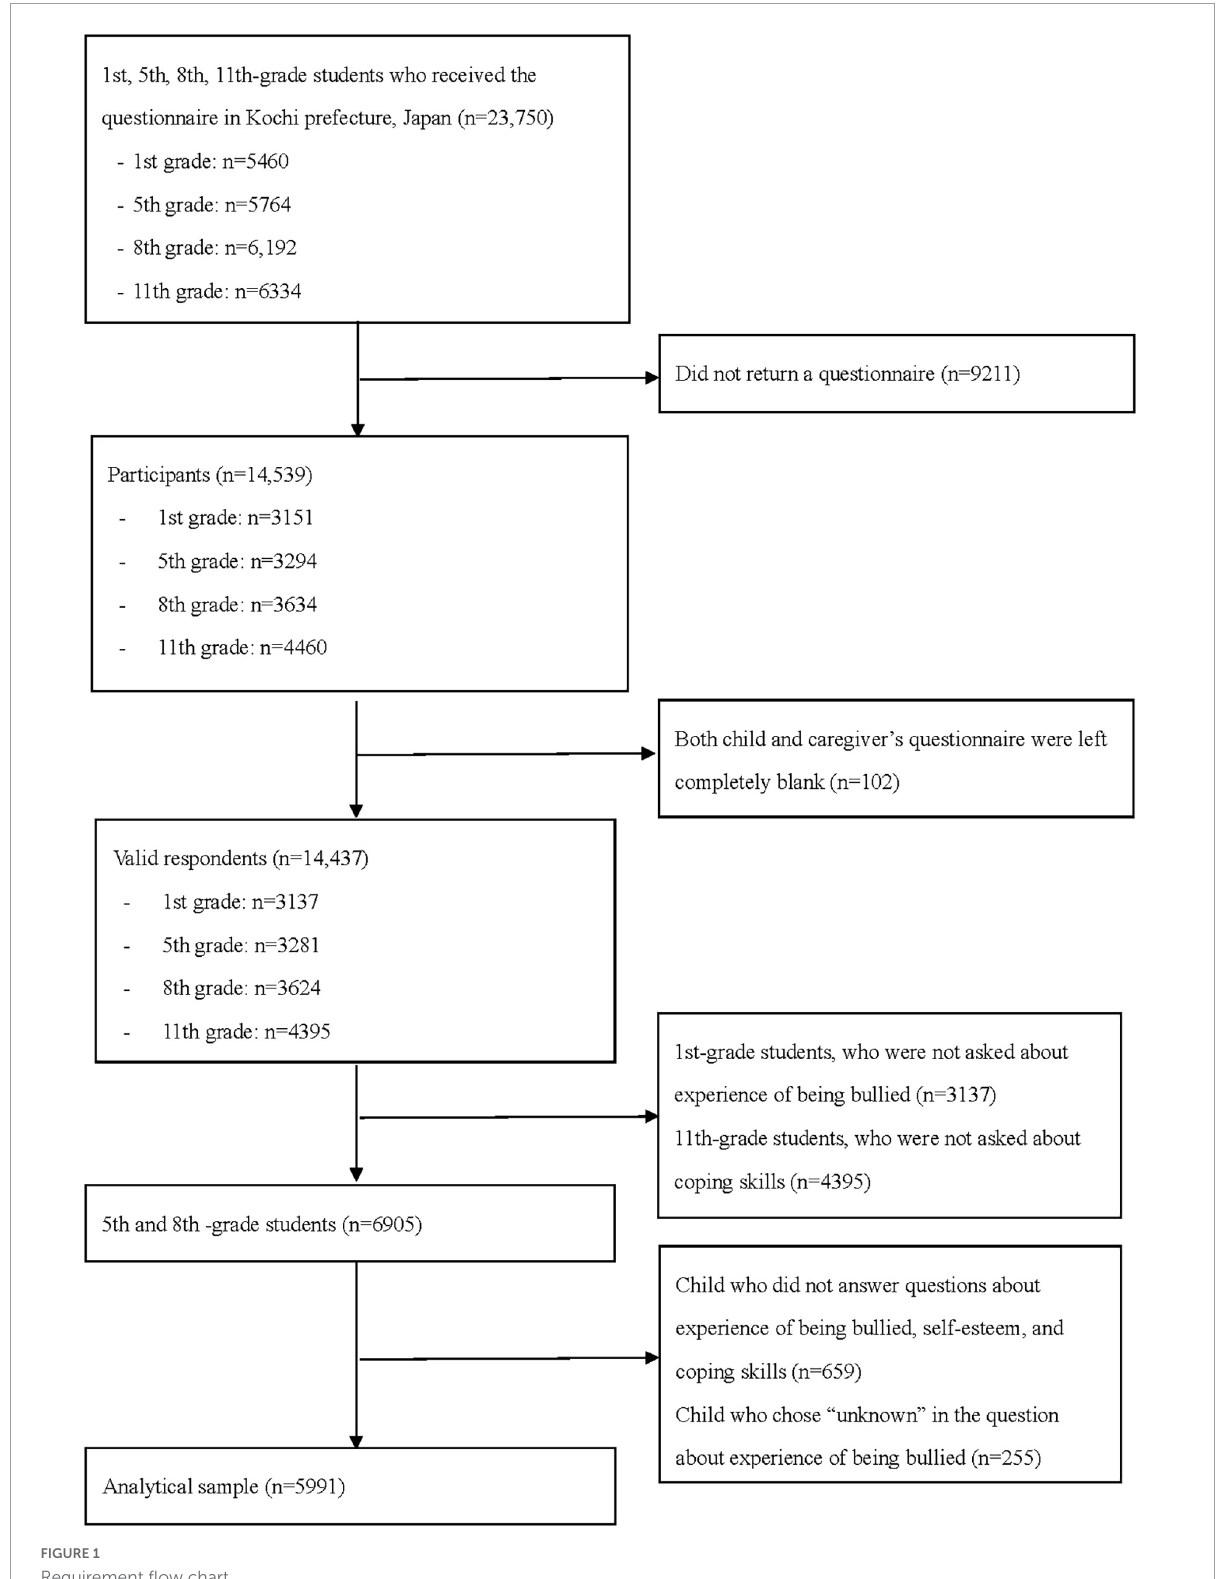
FIGURE1 Requirement flow